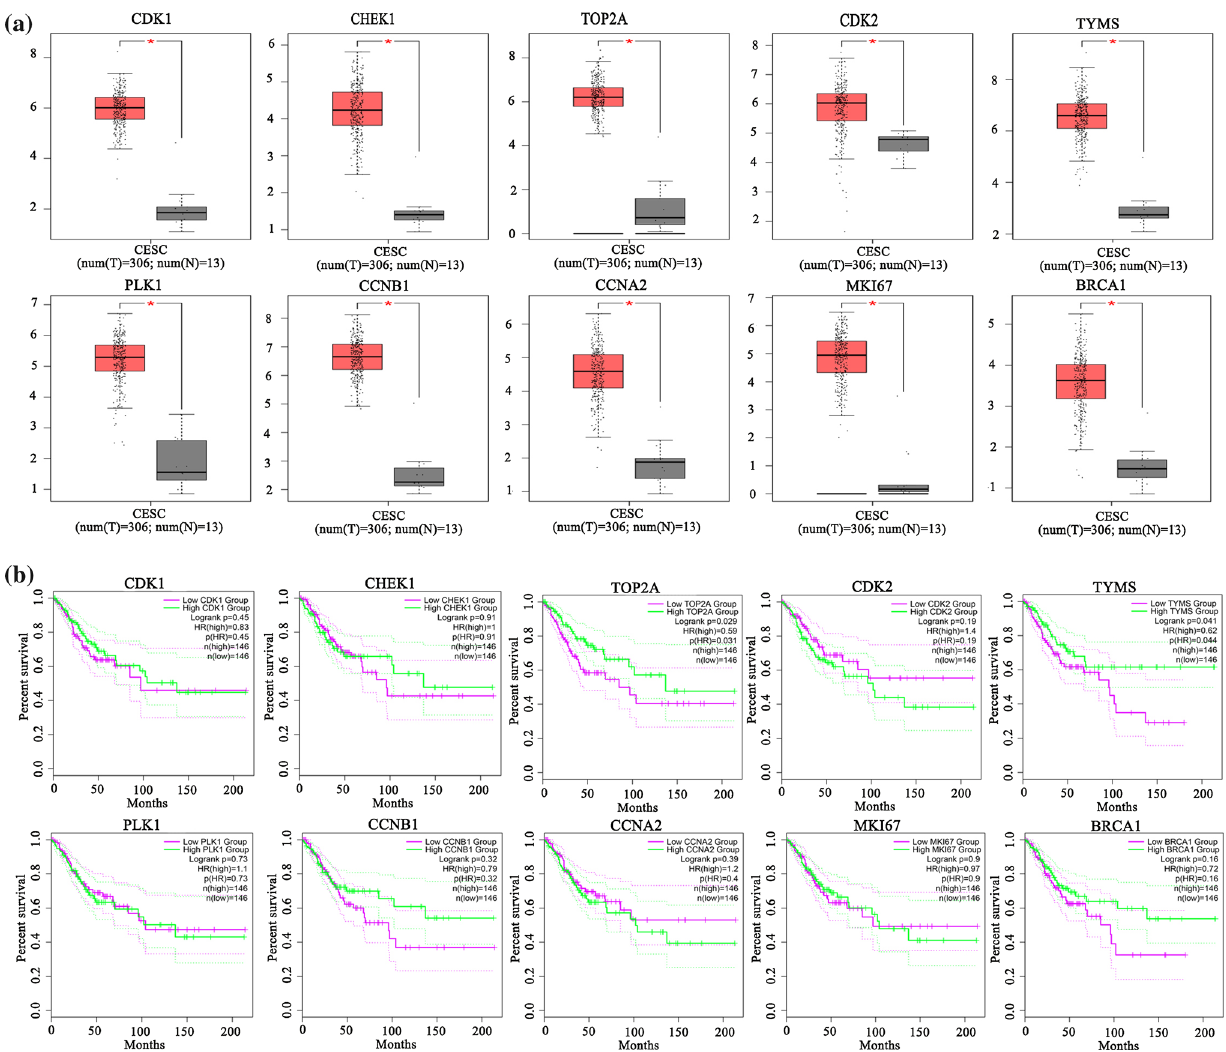
Fig. 3 a Validation of the expression of 10 hHubGs in CC tissues via GEPIA website. Red color represents tumor samples, while gray color represents normal samples. b Overall survival of 10 hHubGs in CC patients. The green curve is the high expression group and the magenta curve is the low-expression